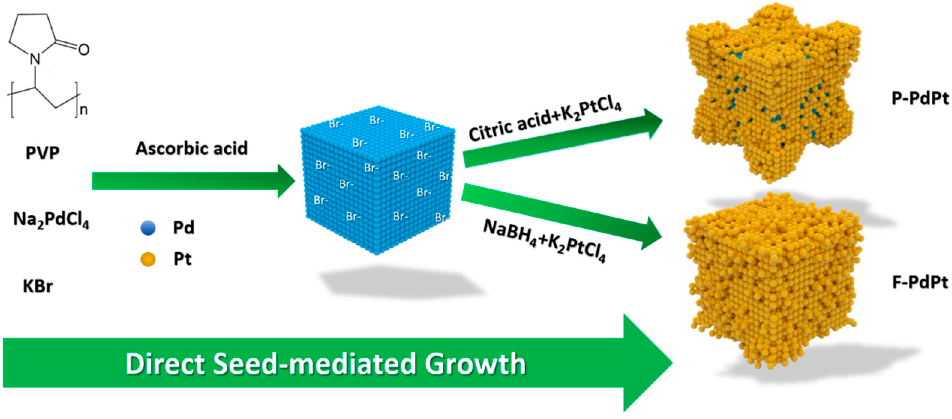
Figure 3. Reaction pathways for the synthesis of P-PdPt and F-PdPt core–shell nanocubes.